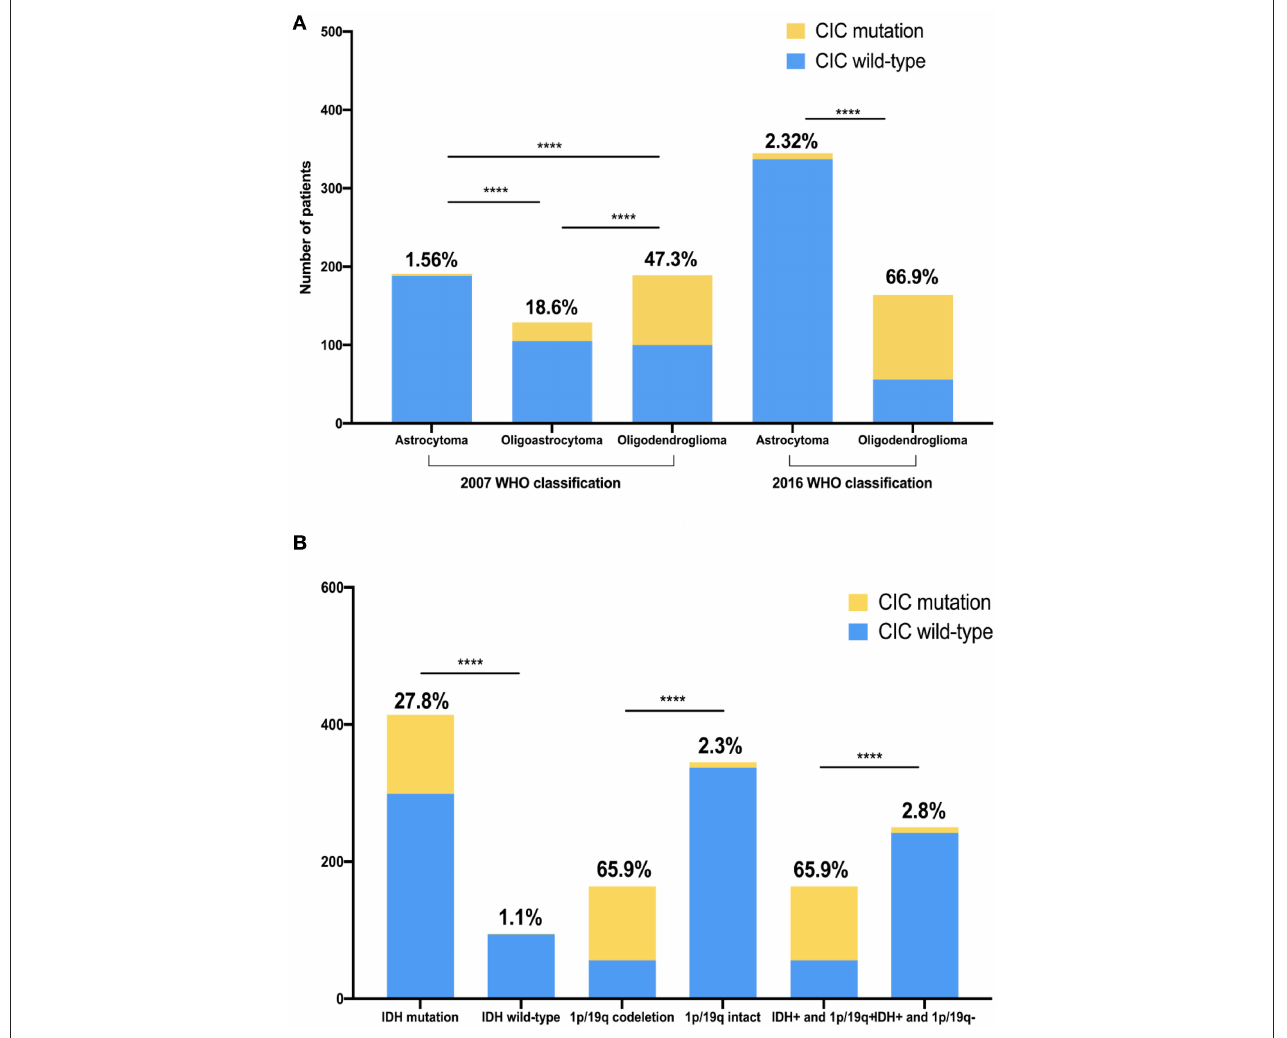
FIGURE 4 | CIC mutation rate is unequal in different glioma classifications and genotypes. (A) CIC mutation in two different WHO CNS tumor classifications. (B) CIC mutation in different genotype glioma. IDH , IDH mutation; 1p/19q , 1p/19q codeletion; 1p/19q-, 1p/19q intact. The value above the bar is the ratio of CIC mutation. + + Chi-square test, **** P < 0.0001.